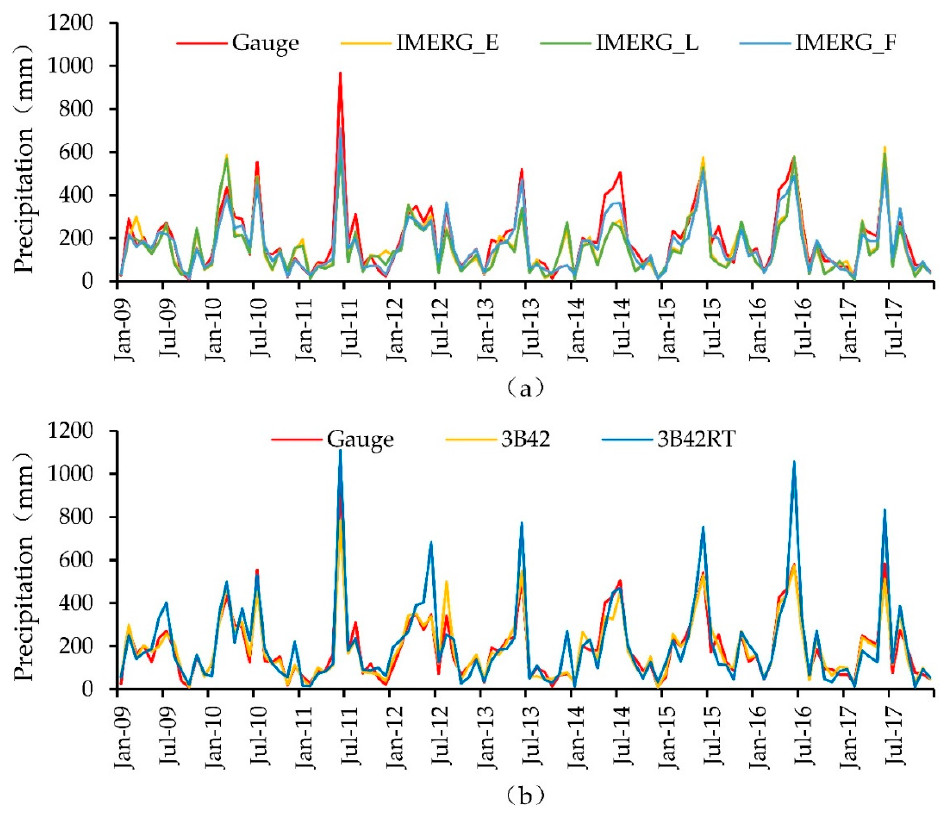
Figure 2. Comparison of mean monthly precipitation observations with the estimates of five SPPs from 2009 to 2017: ( a ) IMERG products; ( b ) TRMM products.